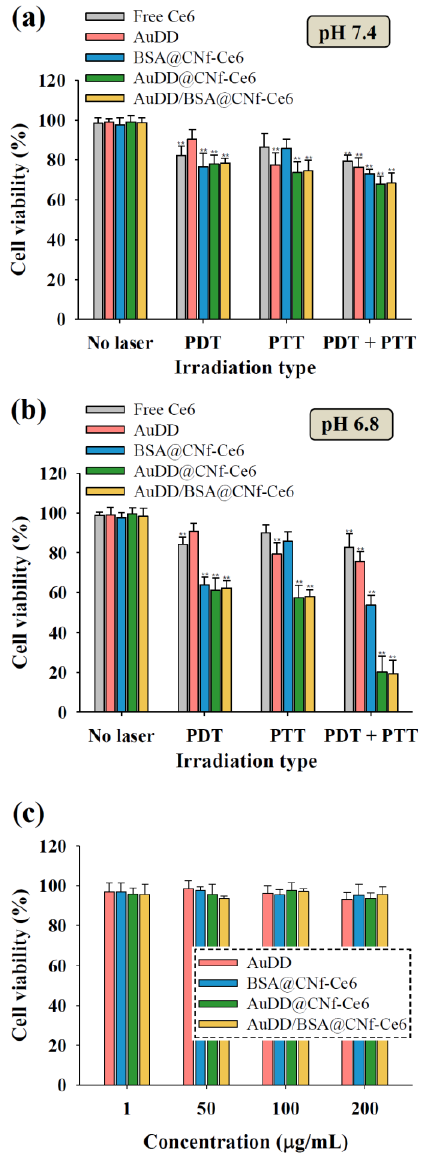
Figure 7. Cell viability of the MDA-MB-231 cells incubated with free Ce6 (10 μ g/mL), AuDD (50 μ g/mL), and CNf-Ce6-based samples (200 μg/mL, equivalent to Ce6 10 μ g/mL) at ( a ) pH 7.4 and ( b ) pH 6.8 (mean ± SD, n = 8, ** p < 0.01 compared to no laser). The cells were irradiated for 10 min at a light intensity of 5.2 mW / cm 2 using a 670 nm laser source and / or for 5 min at a light intensity of 2 W / cm 2 using an 808 nm laser source. ( c ) Cell viability of the MDA-MB-231 cells incubated with AuDD or CNf-Ce6-based samples for 24 h at 37 ◦ C without light irradiation (mean ± SD, n = 8, ** p < 0.01 compared to